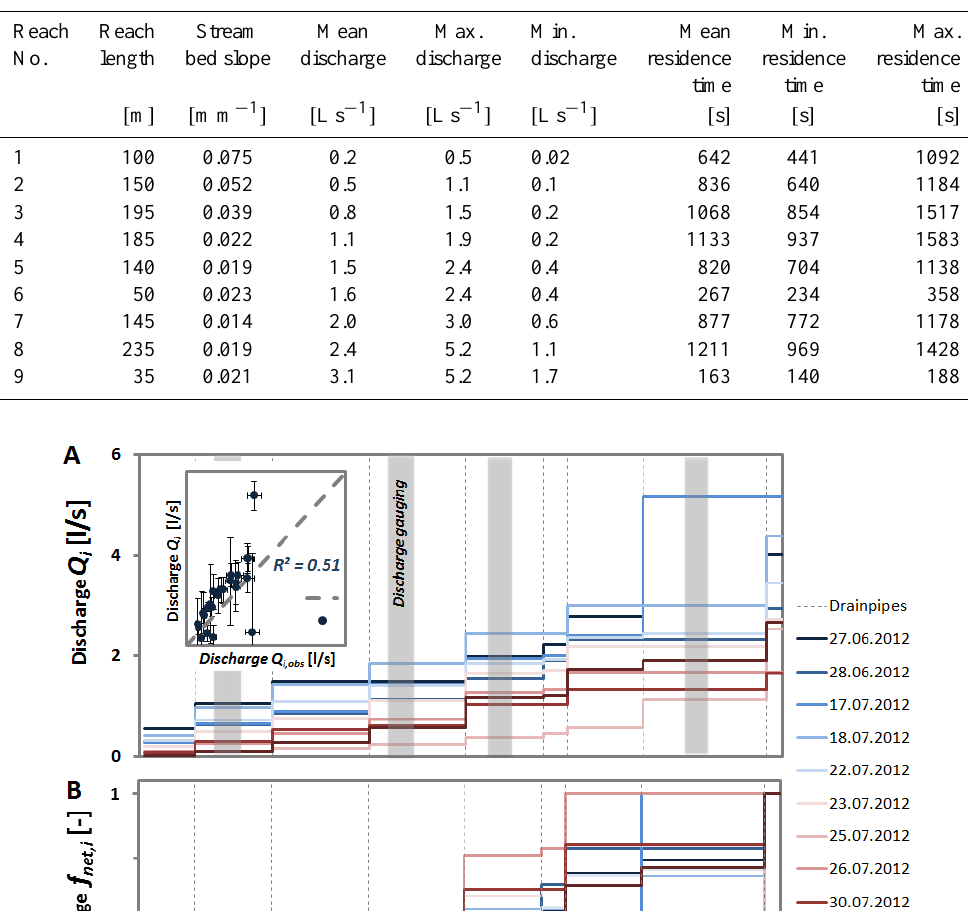
Table 2. Overview on stream reach residence times τ and stream reach specific parameters applied in Eqs. (9) to (12).